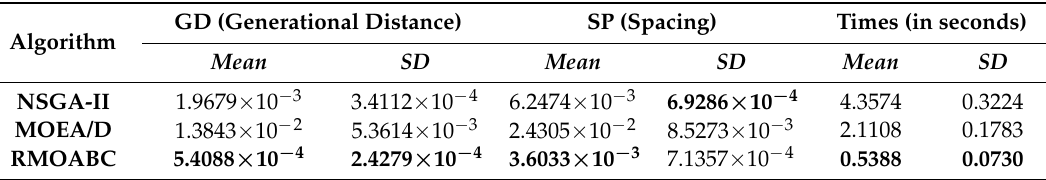
Table 2. Results of the performance metrics for ZDT1 function of the algorithms.